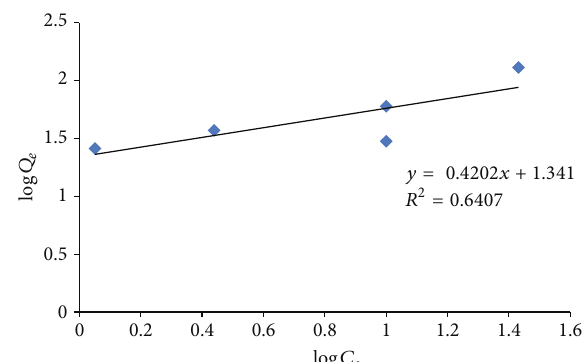
Figure 5: The linear Freundlich adsorption isotherms for BBG dye adsorption by the AC1.